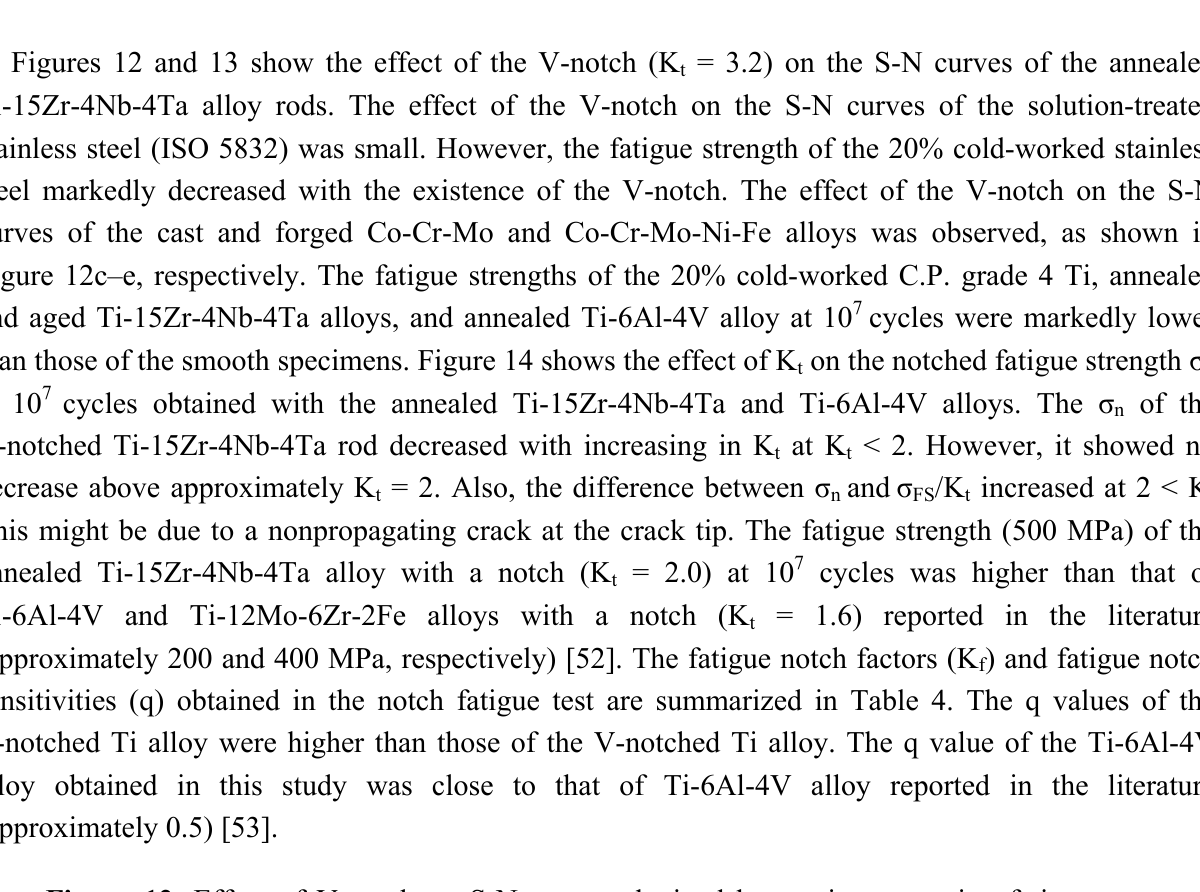
Figure 12. Effect of V-notch on S-N curves obtained by tension-to-tension fatigue test (sine wave, 10 Hz) for implantable